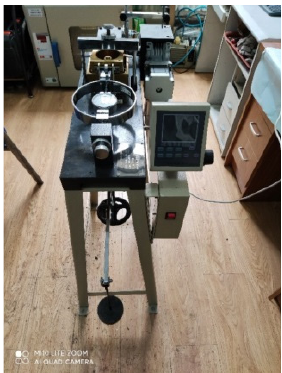
Figure 7. ZJ-1B direct shear apparatus.